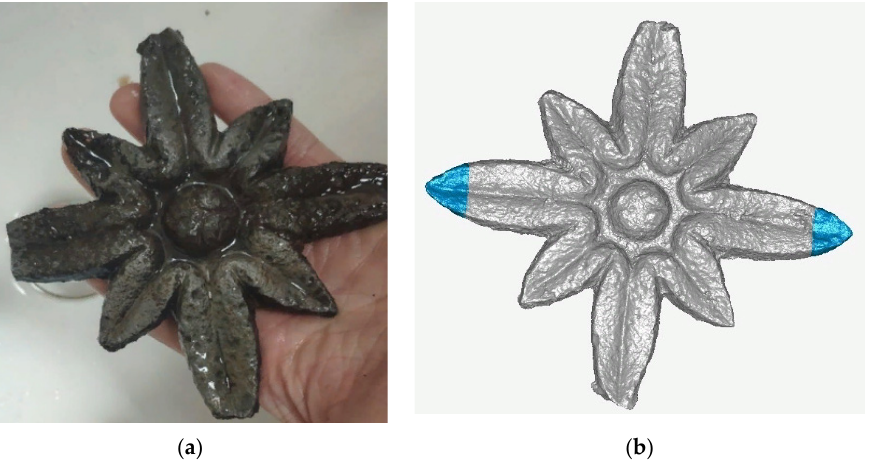
Figure 6. ( a )—star after chemical treatment; ( b )—3D model with added rays.